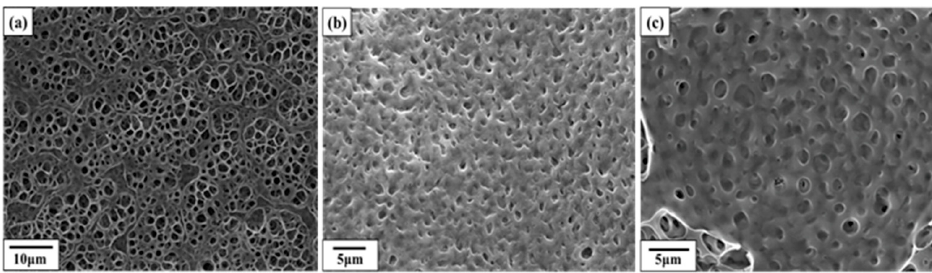
Figure 3. Images of ( a ) and ( b ): the upper surfaces of AC/Gly film before and after water pressure treatment, respectively, and ( c ) the AC side of the PP/AC/Gly separators at 10 bar.